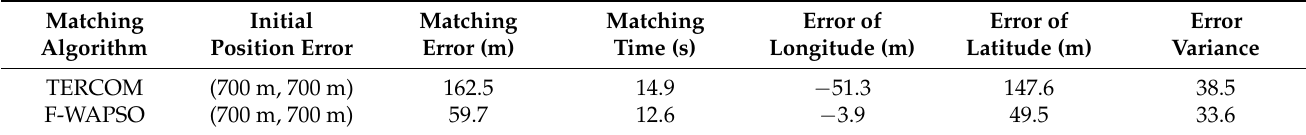
Table 6. Matching and error statistics of the two algorithms for trajectory